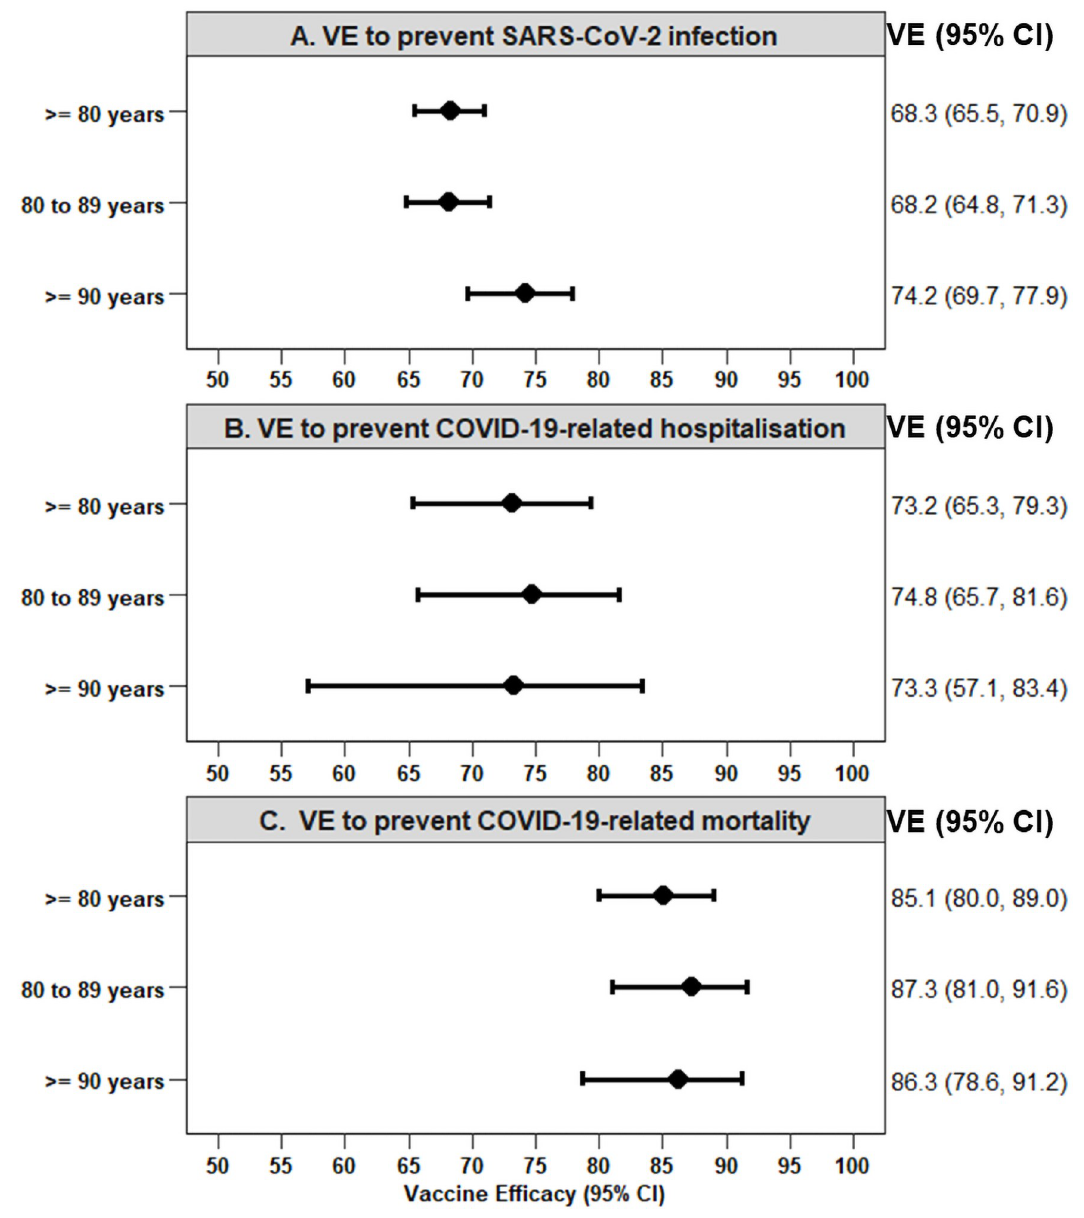
Fig 4. Vaccine effectiveness to prevent SARS-CoV-2 infection and related outcomes after two BNT162b2 vaccine doses compared to none in Bavarian persons aged 80 years and above. Vaccine effectiveness was calculated as 1 –HR, adjusted for sex. CI, confidence interval; HR, hazards ratio; VE, vaccine effectiveness. A. VE to prevent SARS-CoV-2 infection. B. VE to prevent COVID-19-related hospitalisation. C. VE to prevent COVID-19-related mortality.